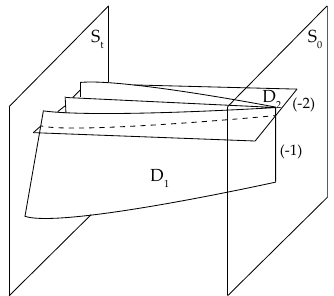
Figure 2: The ramification point of codimension-two D O ( − 1 ) ⊕ O ( − 1 ) curve on S